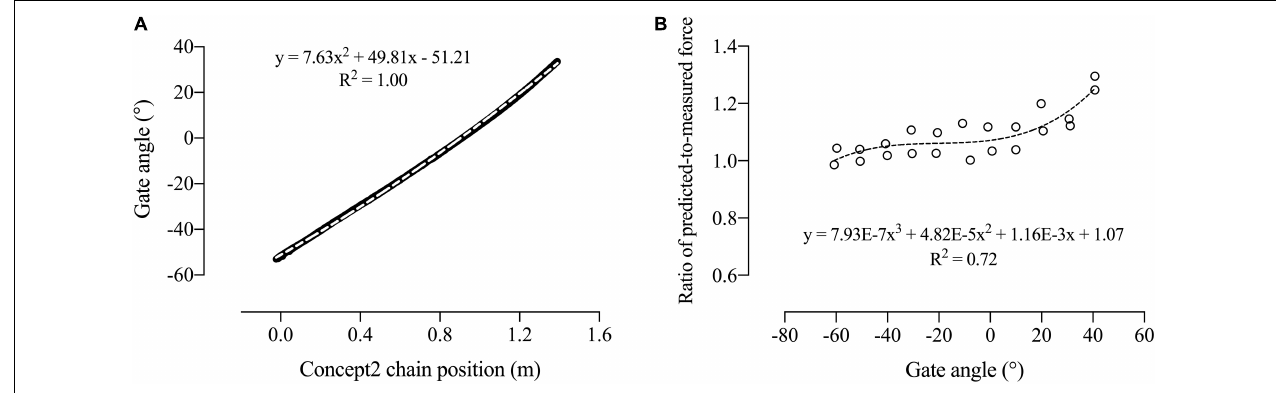
FIGURE 4 | Oarlock angle plotted against Concept2 chain position used to derive a , b, and c in Equation 1 (A) ; and the ratio of predicted-to-measured force plotted against oarlock angle used to derive the coefficients d , e , f , and g in Equation 4 (B) . Dashed lines represent the fitted trendlines.